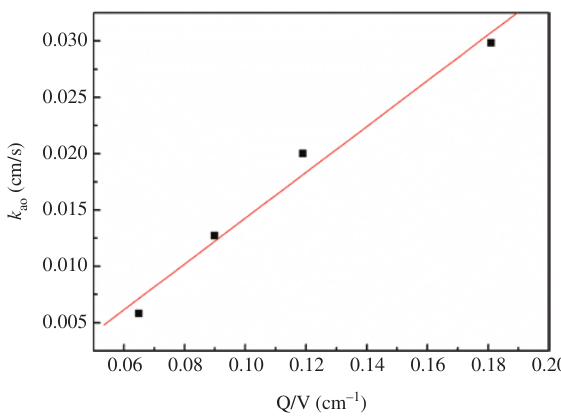
Figure 4: Effect of specific interfacial area on mass transfer rate. Aqueous phase: [CeCl ] = 0.10 mol l −1 , pH = 2.00, [HLac] = 0.3 mol l −1 , 3 [H Cit] = 0.03 mol l −1 ; organic phase: [H A ] = 0.60 mol l −1 ; stirring 3 2 2 speed = 250 rpm, T = 298 K.